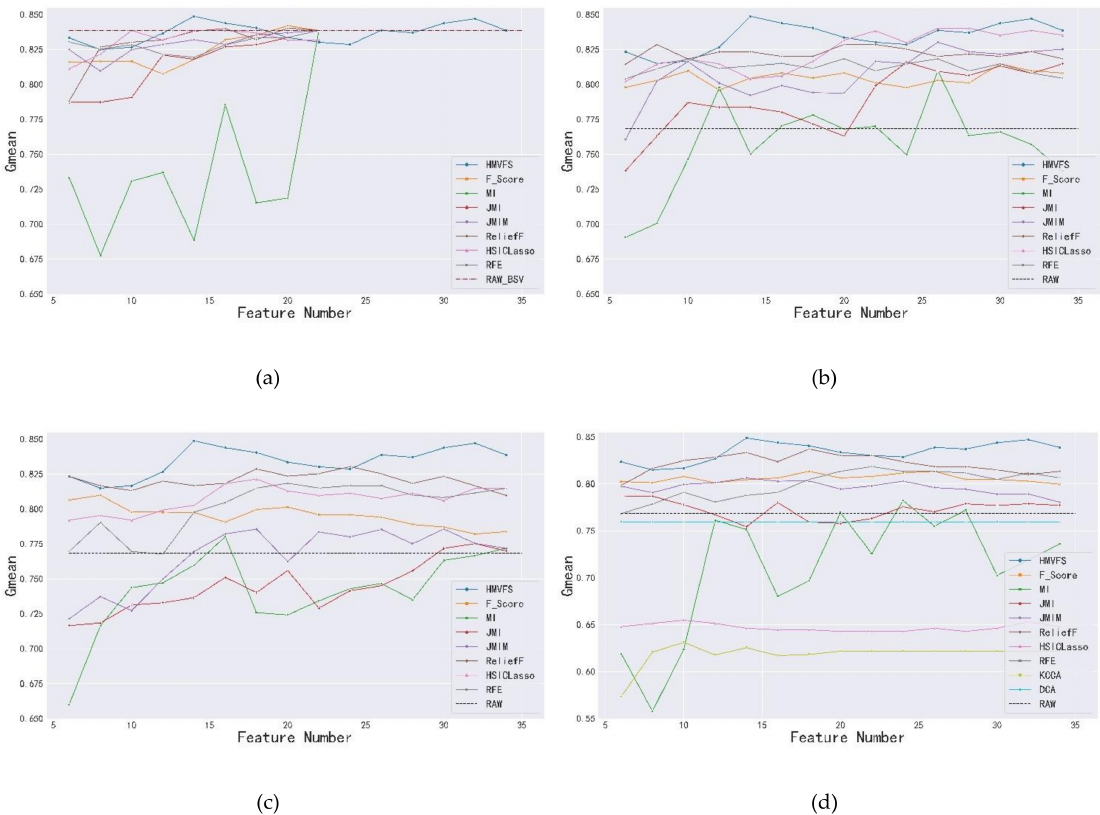
Figure 2. Classification comparison between HMVFS and other feature algorithms in strategies: ( a ) BSV; ( b ) FSFC_rule1; ( c ) FSFC_rule2; ( d )